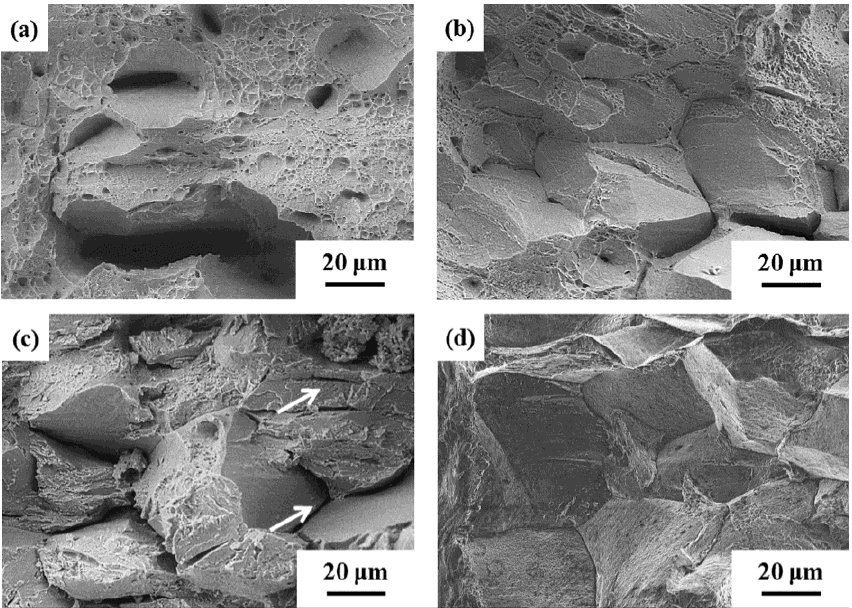
Figure 5. SEM fractographs of ( a ) CR-300, ( b ) CR-450, ( c ) CR-300H, and ( d ) CR-450H specimens after notched tensile test.